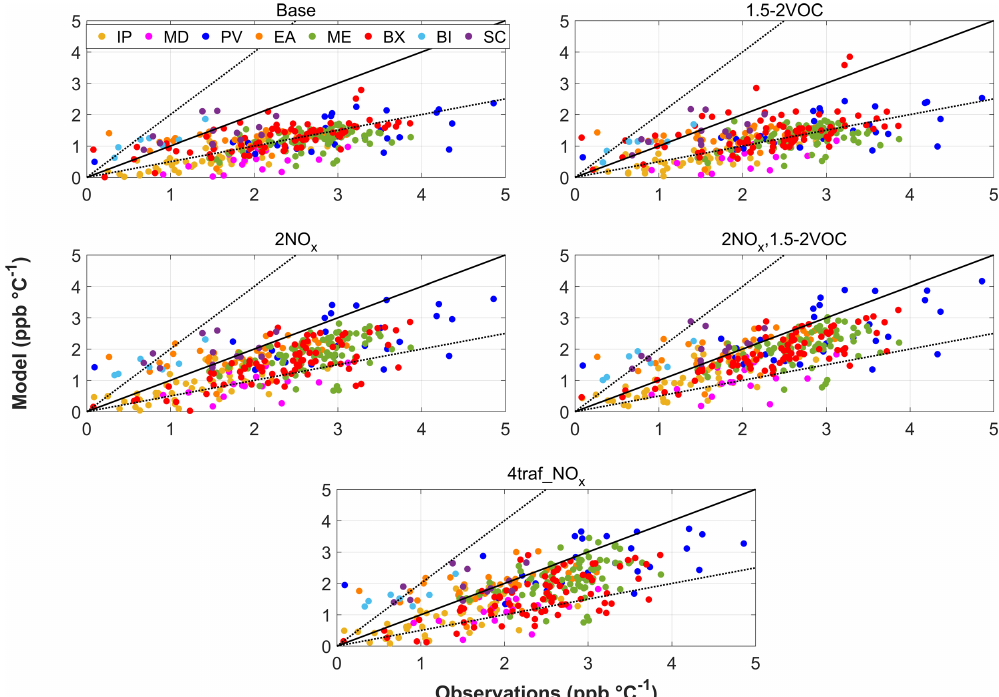
Figure 9. Scatterplots of the modeled vs. observed surface afternoon (12:00–18:00UTC) mean O 3 –temperature linear regression slope for each station for various emission scenarios in eight European regions in summer 2010. The solid black line is the 1:1 line and the dotted black lines are the 2:1 and 1:2 lines. A definition of the regions is given in Fig.